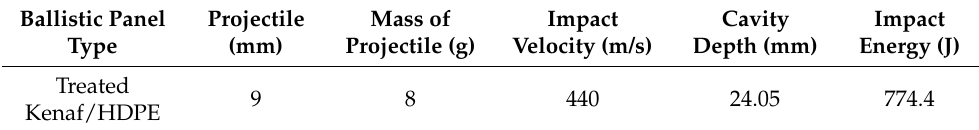
Table 10. Impact test results of kenaf/HDPE panel vest for ballistic